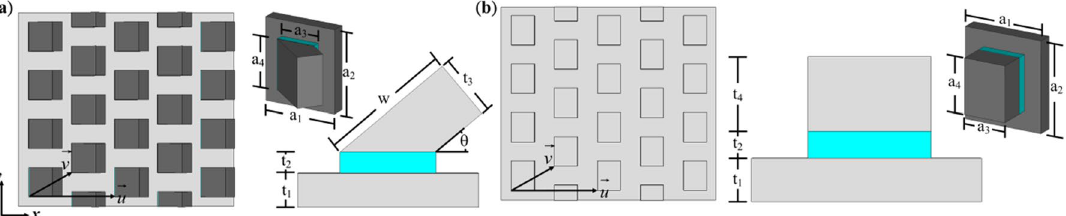
Figure 1. Schemes of ( a ) a single-oblique-flat-sheet metamaterial perfect absorber (SOFS MPA) and ( b ) a planar MPA. Detailed dimensions are a 1 = 740 nm, a 2 = 834 nm, a 3 = 396 nm, a 4 = 508 nm, t 1 = 150 nm, t 2 = 80